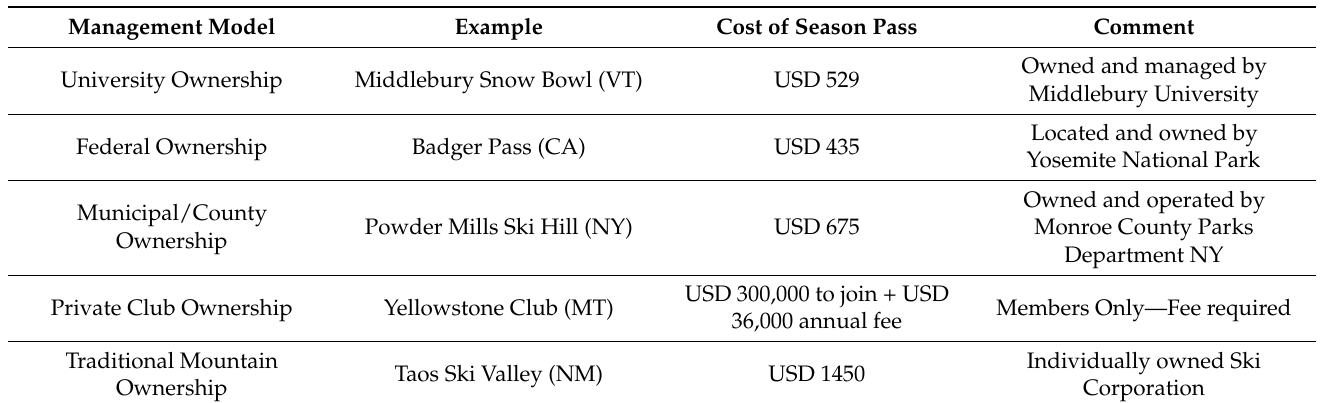
Table 4. Creative models for ski resort